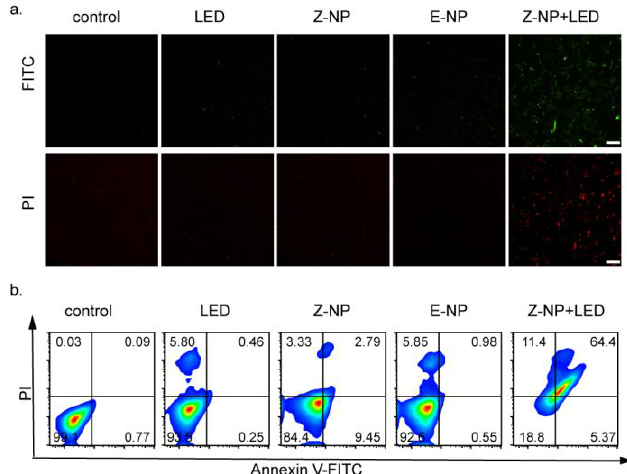
Figure 4. Photodynamic therapy effect of Z-NPs on 4T1 cells assessed by Annexin V-FITC and PI kit. ( a ) Confocal images and ( b ) flow cytometry analysis of apoptosis assay after different treatments. Various therapies were used, including control, LED, Z-NP, E-NP, Z-NP+LED (NP concentration: 15 μM, LED: 520 nm, 40 mW/cm 2 , 5 min, scale bar: 100 μm).